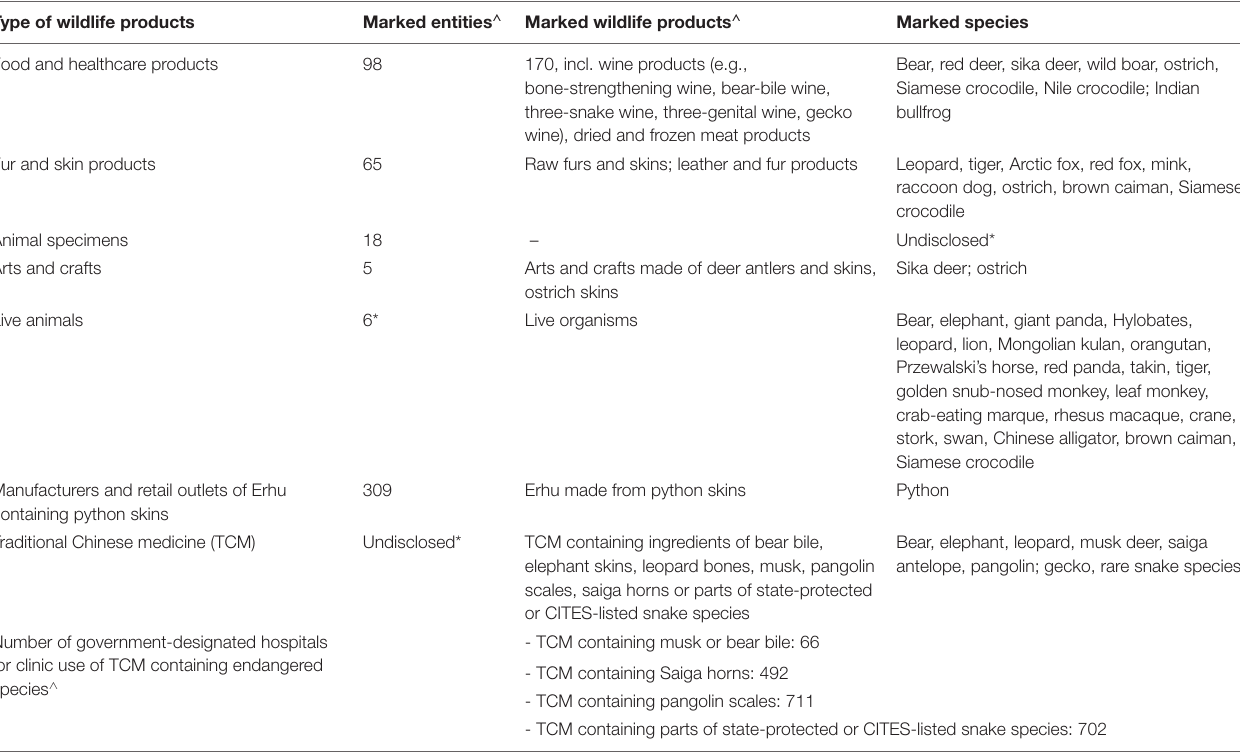
TABLE 2 | Entities and wildlife products covered by the special marking scheme during 2003–2017 #